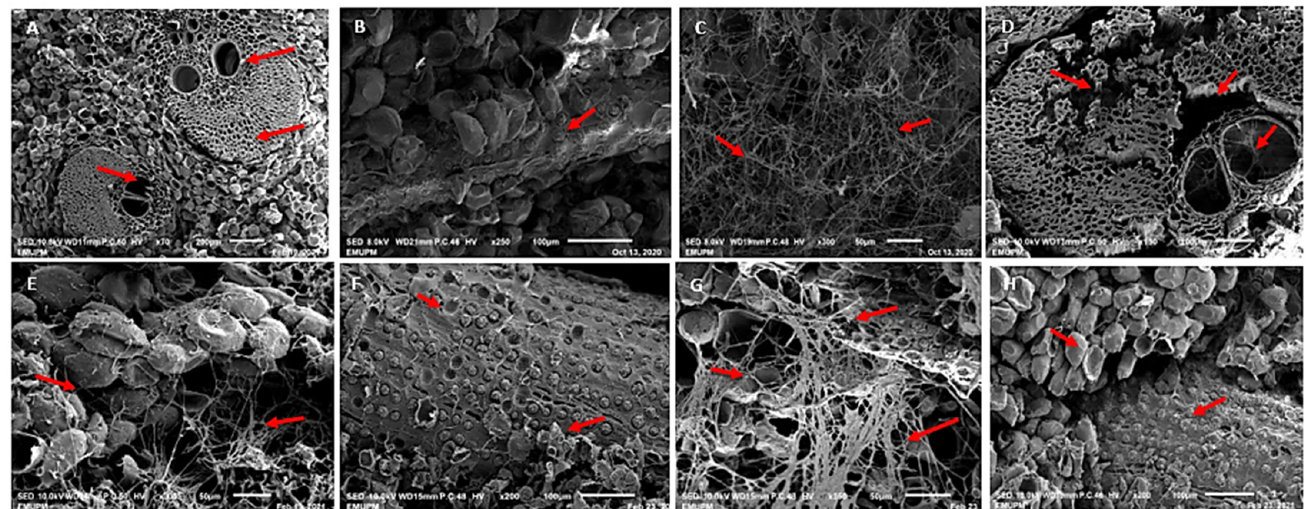
Figure 6. Scanning Electron Micrographs of oil palm wood blocks inoculated with G. boninense . ( A ) Healthy oil palm wood with compact fibres structure, vascular buddle, and parenchymatous cell (arrow). ( B ) Inoculated healthy wood treated with 5.00 mM benzoic acid, showing intact silica bodies and parenchymatous cell 30 days after inoculation. ( C ) Colonization of G. boninense on the surface of untreated wood at 30 days of incubation. ( D ) Inoculated healthy wood treated with 4.00 mM benzoic acid showing separated fibers and hyphae appear thin in structure (arrow) 30 days after inoculation. ( E ) G.